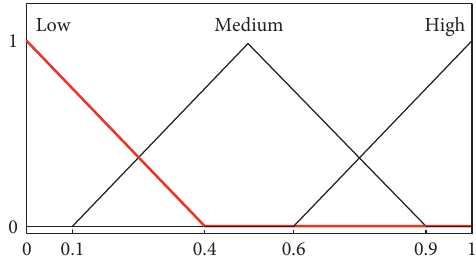
Figure 16: FV membership functions for LV v